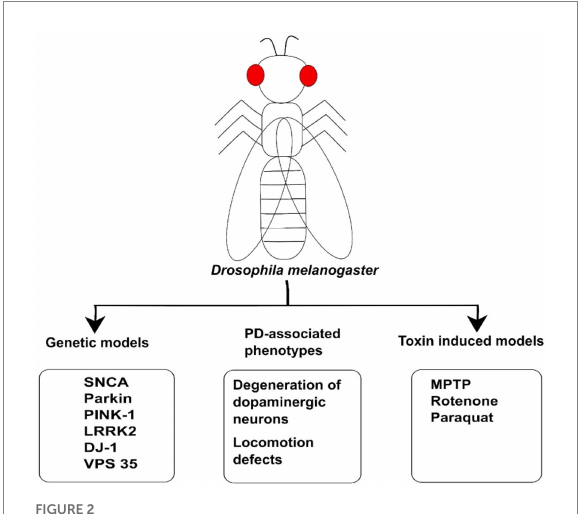
FIGURE 2 The illustration of Drosophila model used for Parkinson’s Disease. Genetic models such as SNCA, LRRK2, DJ-1, Parkin , and PINK1 have been used to study the molecular mechanism of PD. These animal models have been generated on the basis of genetic mutation in the genes linked to disease. The toxins such as MPTP, Rotenone, and Paraquat have also been used to induce PD- associated phenotypes in Drosophila model. These models can also be employed for investigating PD and developing therapeutic drugs against